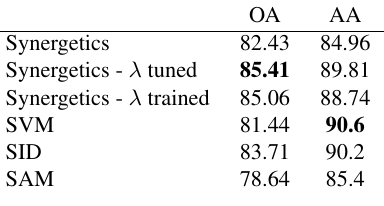
Table 1: Classification results for the Salinas dataset, in terms of Overall Accuracy (OA) and Average Accuracy